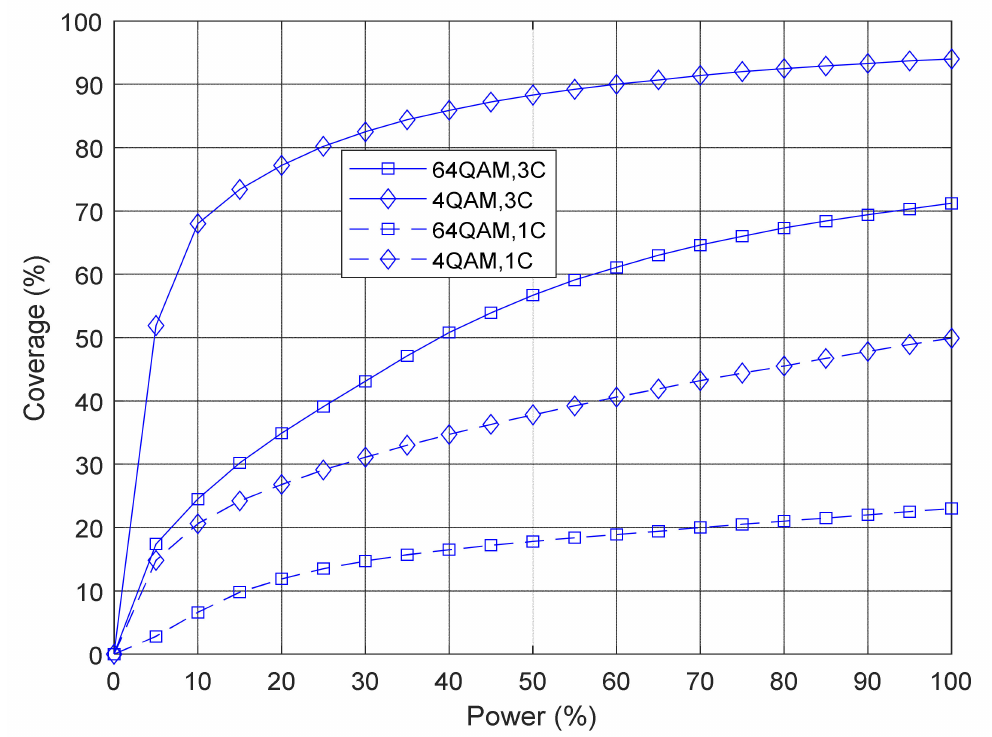
Figure 14. Coverage vs. percentage of TRP transmitted power, for UMa scenario, with N tx /N u = 8, N sc = 256, N rx = 5, 64QAM with 12.5 bpcu and 4QAM with 6.5